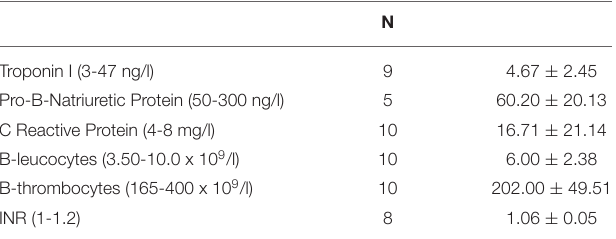
TABLE 2 | Table showing the results for blood serology at the time of acute illness. Brackets contain normal values.